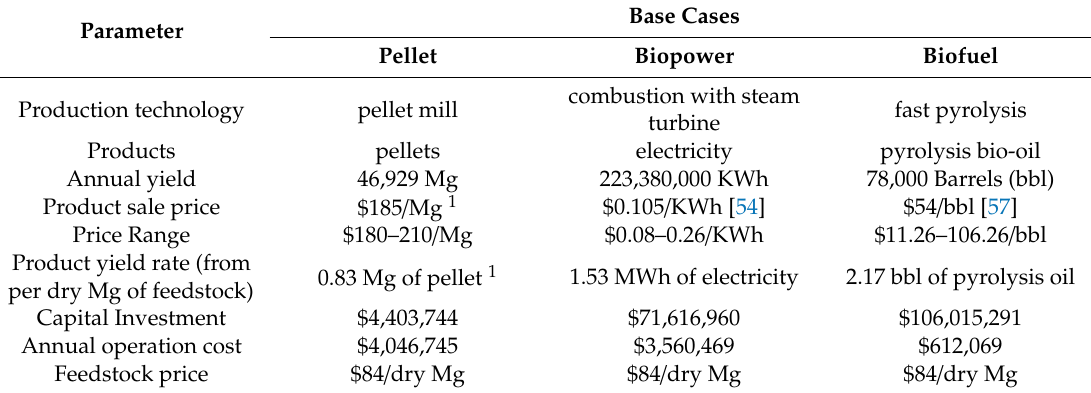
Table 1. Parameter configurations for base case analysis.